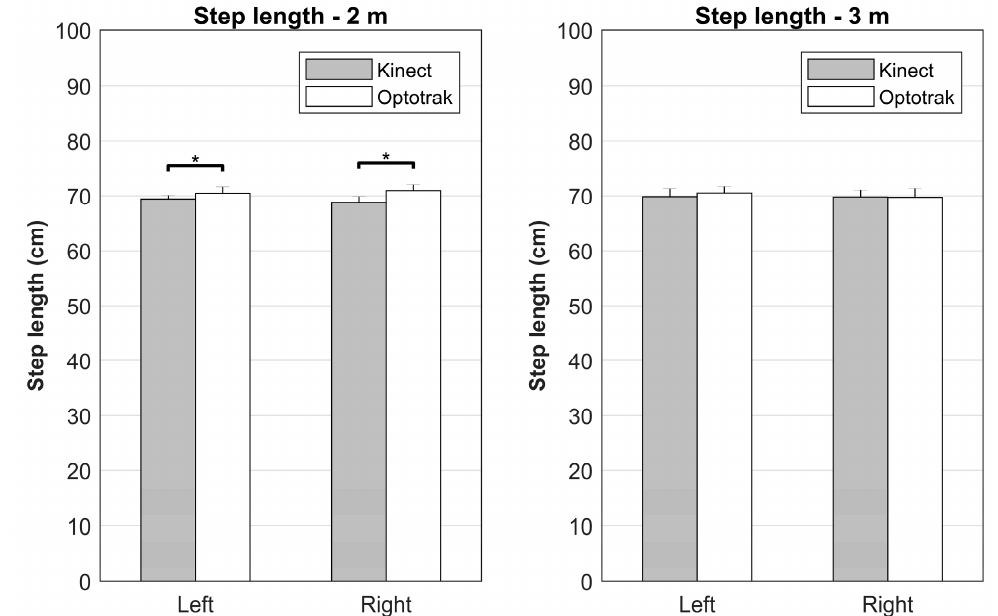
Figure 3. Visual representation of the interaction effect of System, Distance, and Side. The significant between-systems bias in step length was only found at the 2 m distance (indicated by the asterisks) and more strongly so for right step lengths (indicated by the significantly larger between-systems difference for the right step length).